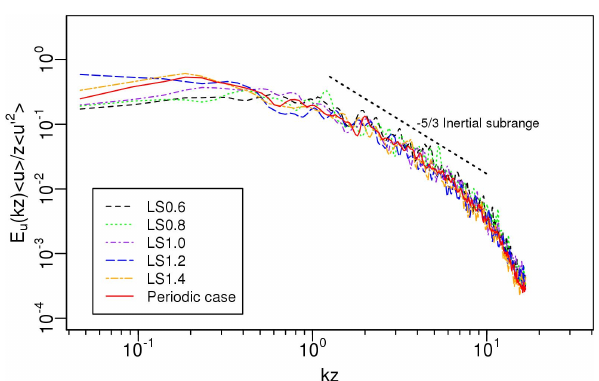
Figure 10. Spectra of streamwise velocity component for a series of downwind locations at x/H = 10 and z/H = 0 . 5 with various integral length scales; k is the angular wavenumber, with (cid:104) u (cid:105) and (cid:104) u (cid:48) 2 (cid:105) the spatially averaged mean and streamwise normal turbulent stress,